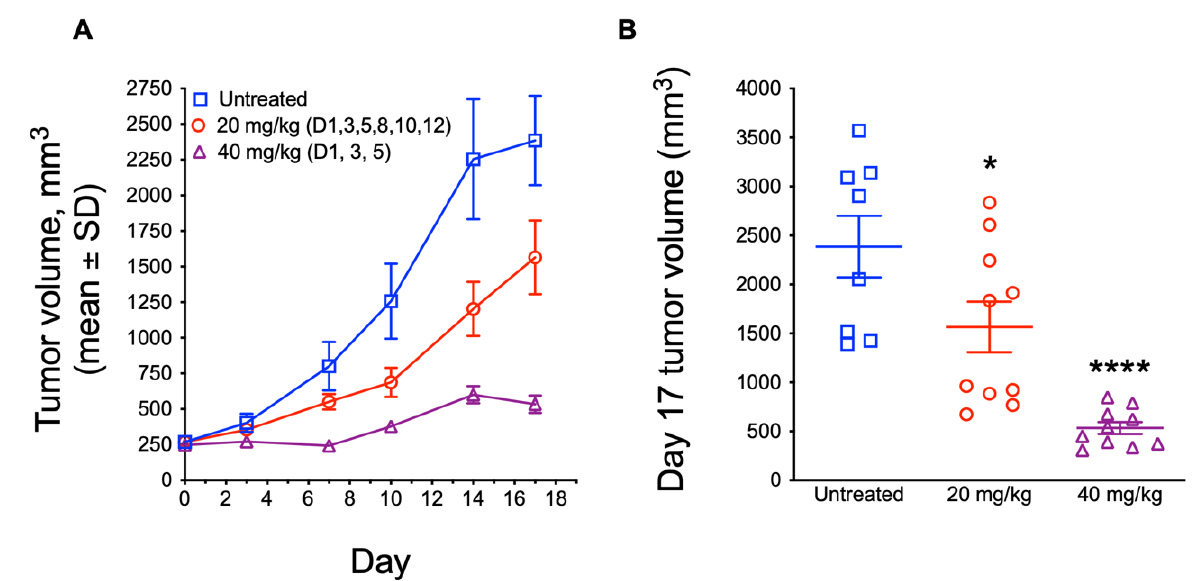
Figure 7. ATXII shows dose-dependent antitumor efficacy against an A-673 xenograft model. ( A ) Tumor growth curves for untreated control and ATXII-treated mice. The mice were injected i.p. with 20 mg/kg ATXII on days 1, 3, 5, 8, 10, and 12 or 40 mg/kg on days 1, 3, and 5. n = 8–10 tumors per group. ( B ) Comparison of final tumor volumes on day 17. * p ≤ 0.05, **** p ≤ 0.0001 compared to untreated control; one-way ANOVA with Tukey’s post-hoc test.